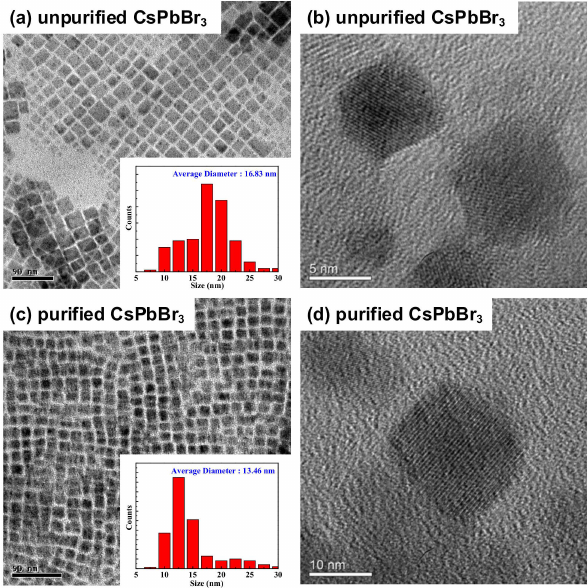
Figure 6. Transmission electron microscopy (TEM) images and insert are the size distribution analysis of ( a ) and ( b ) unpurified QDs-CsPbBr 3 , ( c ) and ( d ) purified QDs-CsPbBr 3